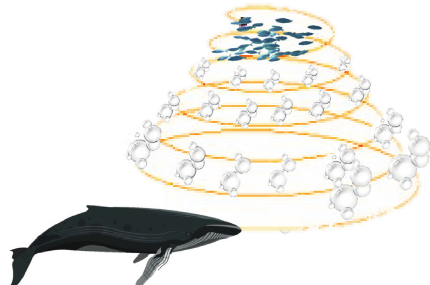
Figure 1: Hunting behavior of humpback